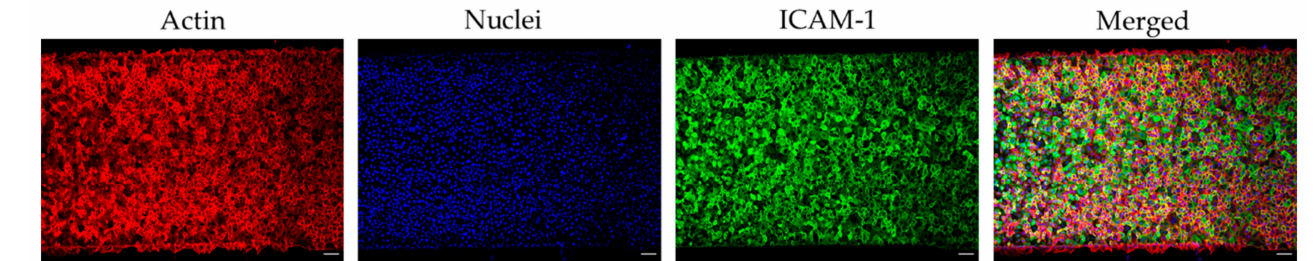
Figure 2. Microchannel coated with tumour necrosis factor alpha (TNF- α ) treated human umbilical vein endothelial cells (HUVECs). Confocal micrographs showing tile-scans of endothelialised devices stained for actin (red), nuclei (blue), and intercellular adhesion molecule 1 (ICAM-1) (green). Scale bars represent 100 µ m.